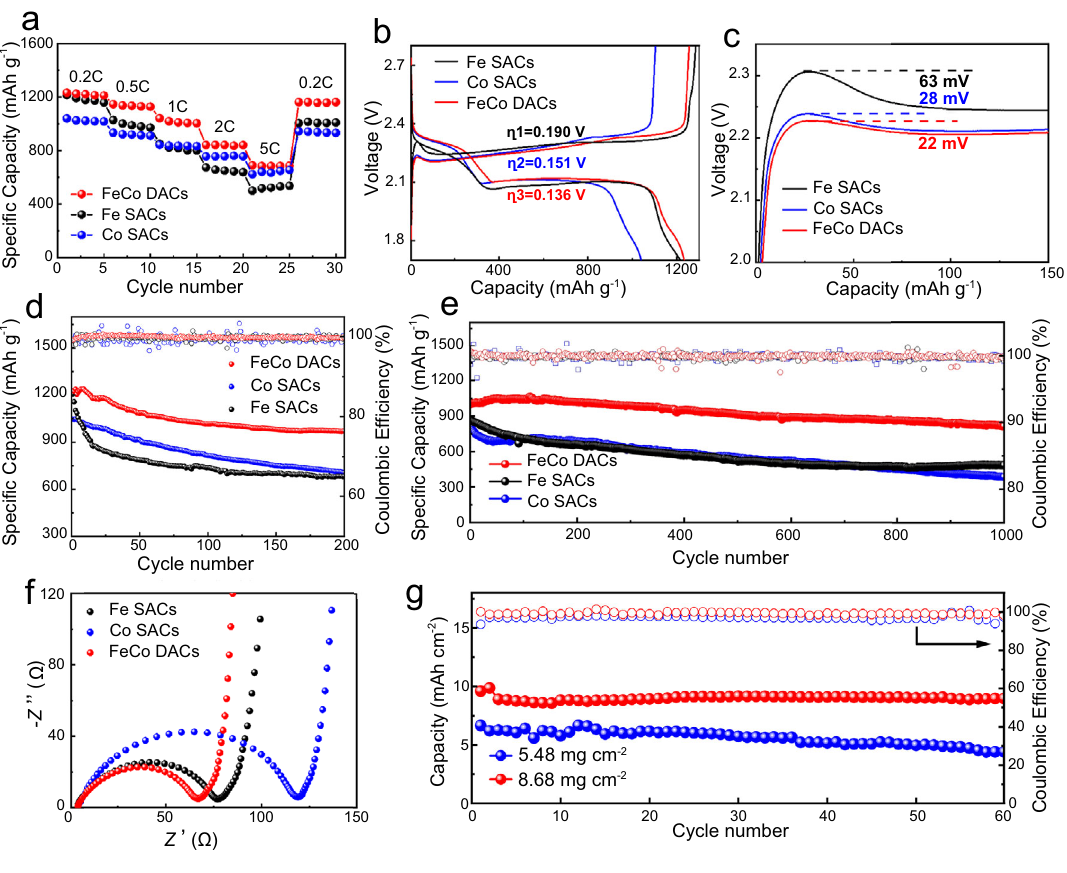
Fig. 6 | Electrochemical performance of Li-S batteries based on different cathodes. a Rate performance at different speci fi c current (1C corresponds to 1675mA g − 1 ). b Corresponding galvanostatic charge-discharge curves at